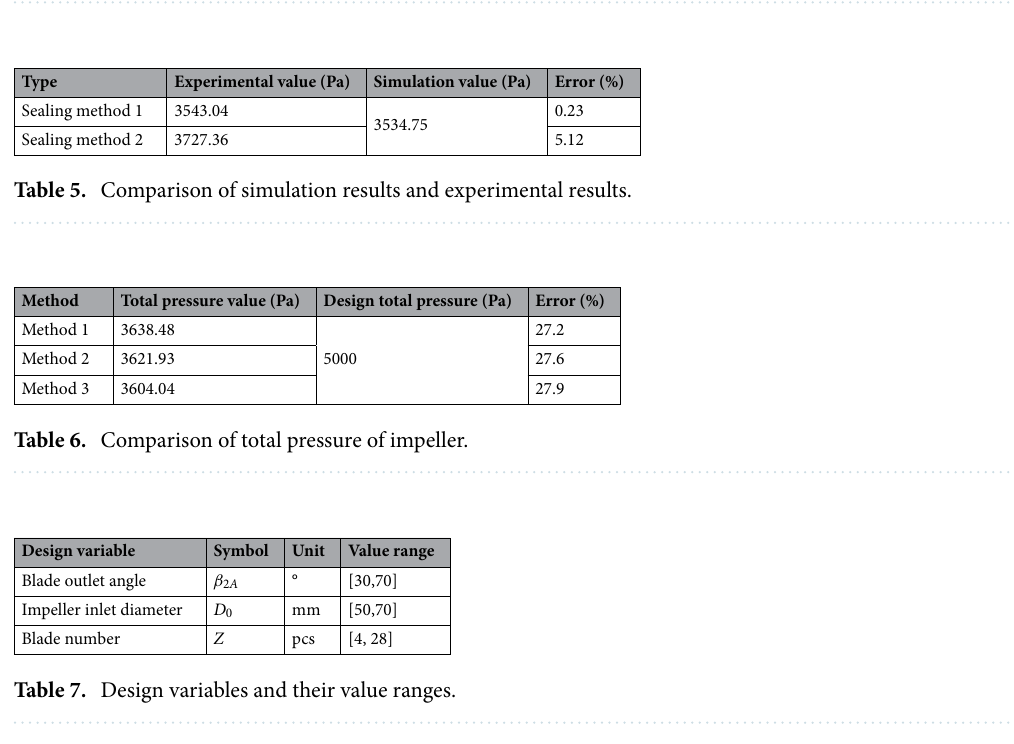
Table 4. Simulation results of negative pressure value.